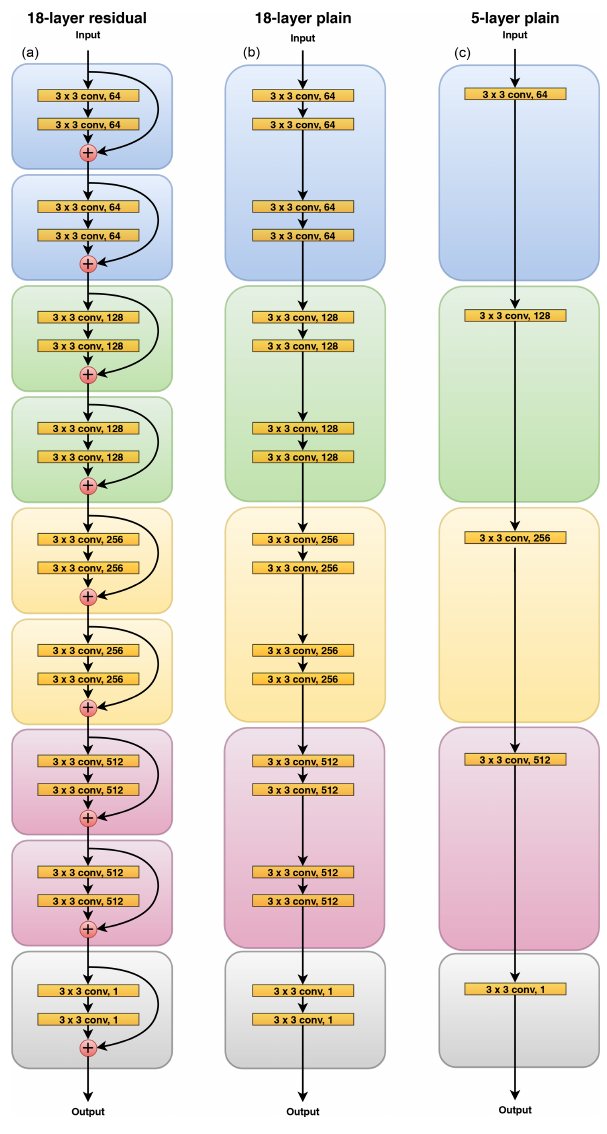
Figure 1. Deep architectures for precipitation forecasting: (a) 18- layer residual network, (b) 18-layer plain network (no shortcut con- nections), and (c) 5-layer plain network (no shortcut